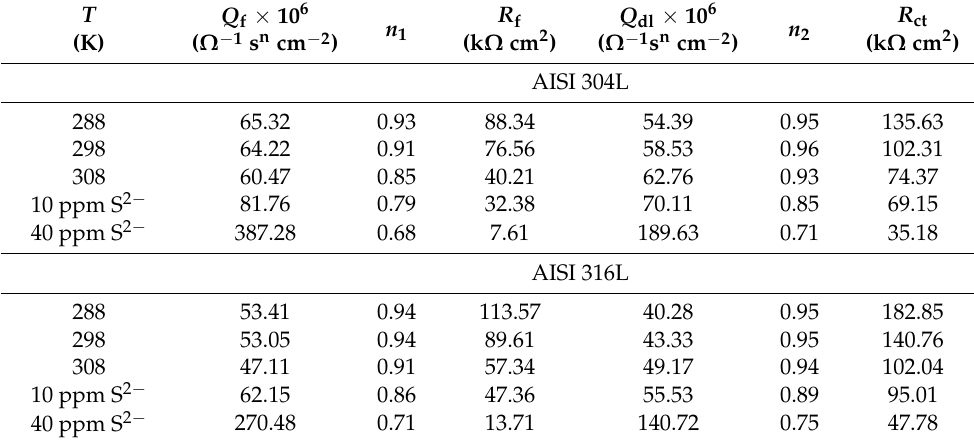
Table 4. Parameters of the equivalent circuit for AISI 304L and AISI 316L stainless steel in seawater at different temperatures and S 2 − concentrations (at 298 K).